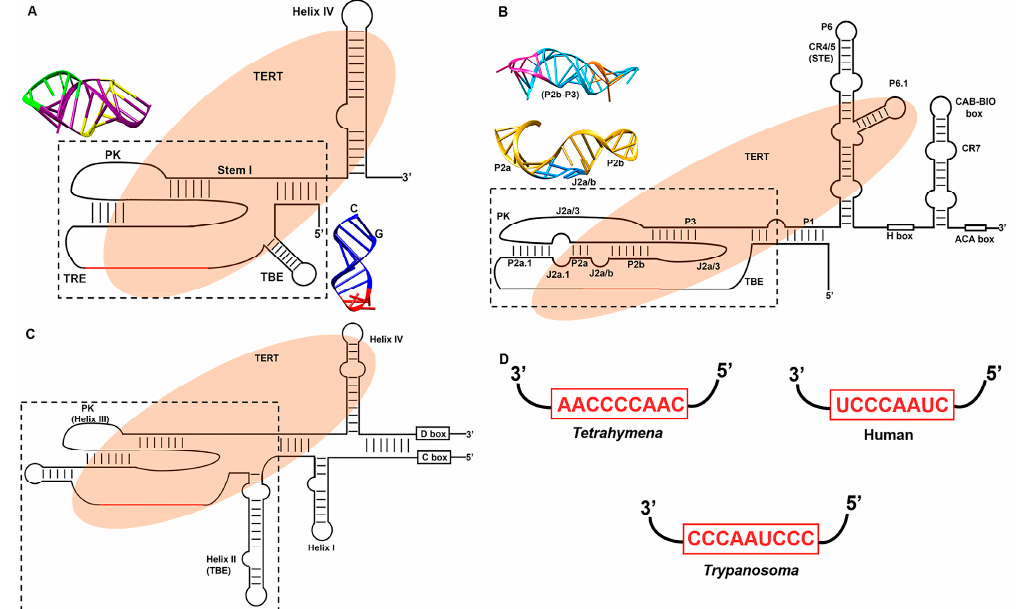
Figure 3. ( A – C ) Secondary structure of telomerase RNAs from Tetrahymena , human and Trypanosoma brucei NMR structure of TER domains are shown in colors. ( A ) Different domains of Tetrahymena TER are indicated as Template Boundary Element (TBE), Template Recognition Element (TRE), Pseudoknot (PK), Stem I and Stem Terminus Element Helix- IV. Also shown are: TBE (PDB ID: 2m22) with CG base pairing at stem terminus and red penta-nucleotide loop at apical position, triple helix PK (PDB ID: 5kmz) with turns in yellow and green. ( B ) In addition to above domains, human TER has long base paired PI, Stem Terminus Element CR4/5 and 3 ′ end with an H/ACA scaRNA domain comprised of H box, ACA box and in between CR7 stem loop having CAB box and BIO box at apical end. Also shown are NMR structure of domains: P2a-J2a/b (blue)-P2b (PDB ID: 2l3e) and triple helical P2b-P3 (PDB ID: 1ymo) with turns in magenta and orange of PK. ( C ) Secondary structure of Trypanosoma brucei telomerase RNA. Different domains are represented as Stem-loop Helix I, Template Boundary Element (TBE) as Helix II, Pseudoknot (PK) as Helix III, Stem Terminus Element as Helix IV and CD box domains at 5 ′ and 3 ′ end respectively. The template region is highlighted in red. Boxed area in TERs represent the catalytic core. TERT protein is shown as shaded region. ( D ) Sequence diversity between Tetrahymena , human and Trypanosoma TER template region are shown.